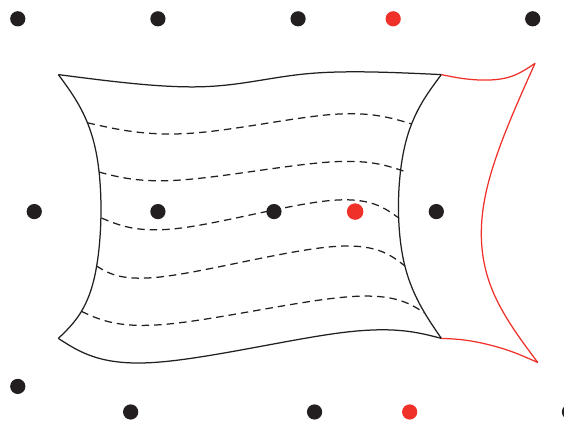
Figure 1: Distribution of control points on the trimmed surface of objects transported in the supply